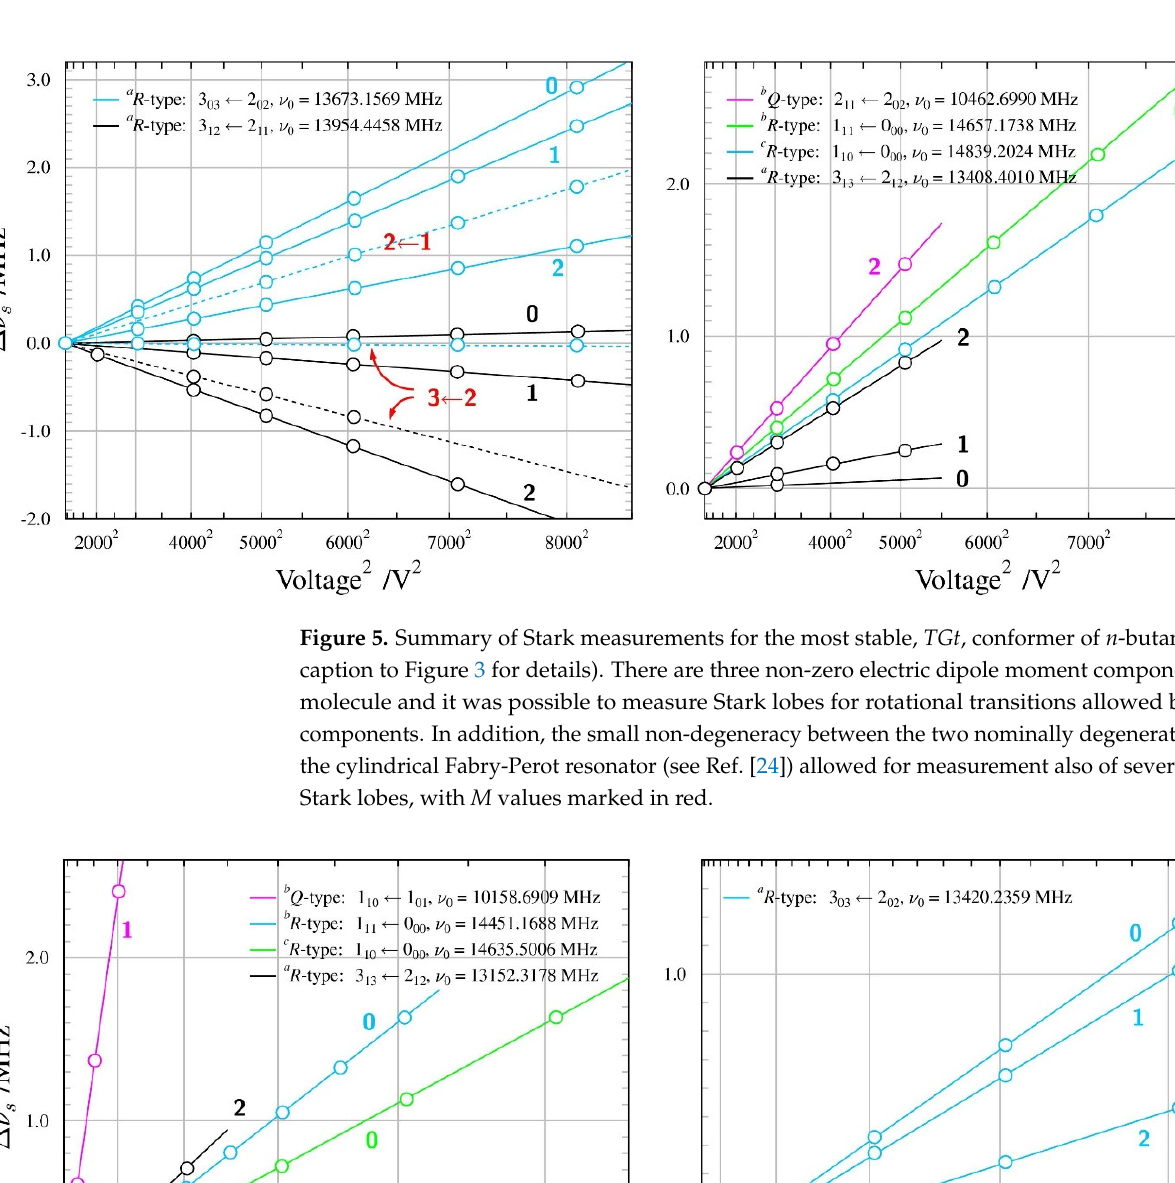
10 of 18 Table 3. Electric dipole moments of the TGt and GTg’ conformers of n -butanol. n -Butanol TGt 3.12 a See the corresponding footnote to Table 2 for explanation of the parameters. b Equilibrium values computed at the cam -B3LYP/6-311++G(d,p) level. c Vibrationally averaged values computed at the MP2/aug-cc-pVDZ level. d Equilibrium values computed at the MP2/aug-cc-pVDZ level. e Equilib- rium values computed at the B3LYP/6-311+G(2d,p) level. The Stark measurements on the TGt conformer were made on supersonic expansion using the standard Ar carrier gas. The transitions of the GTg’ conformer were too weak under these conditions, so the supersonic expansion was generated by diluting the sample in Ne carrier gas, as for the Aa conformer of n -propanol. The obtained results are summa- rised in Figures 5 and 6 and in Table 3. The only previous dipole moment values available